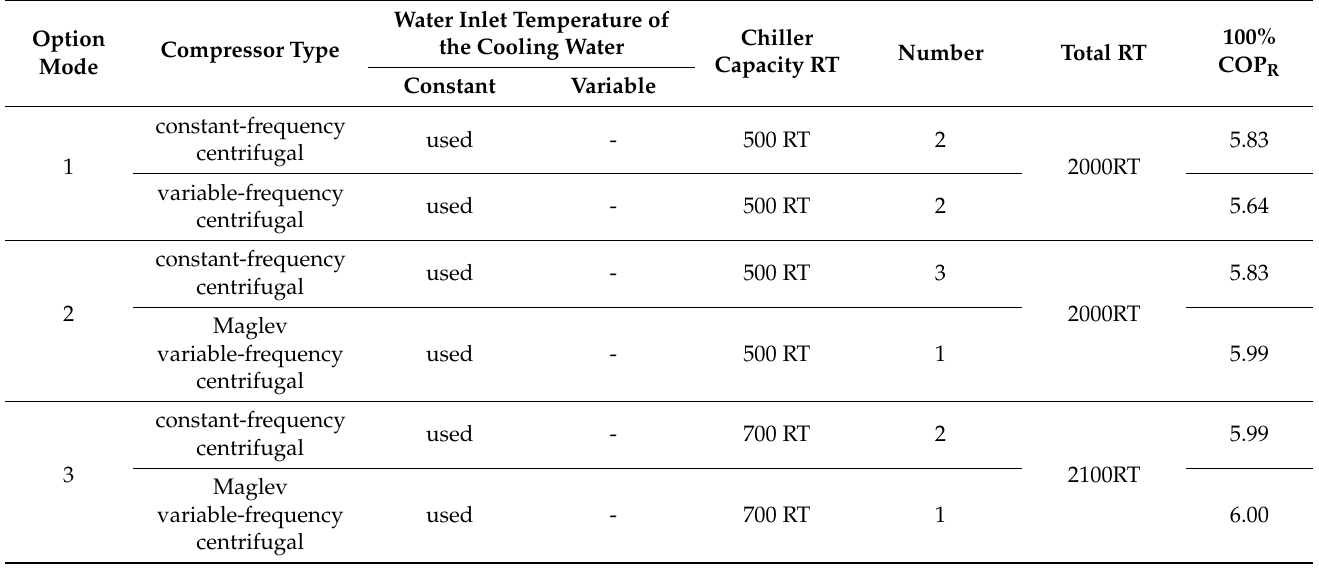
Table 8. Case study analysis